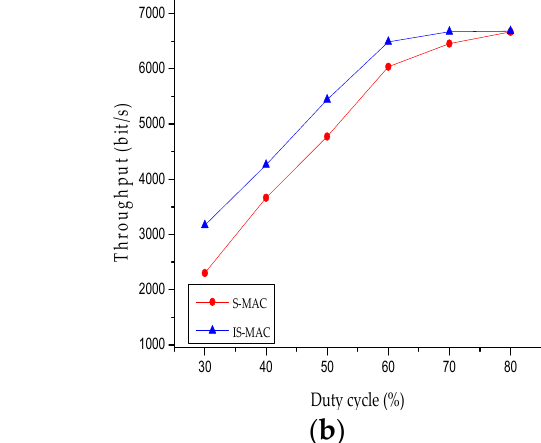
Figure 4. ( a ) Energy consumption of S-MAC protocol and IS-MAC protocol under different duty cycles; ( b ) throughput of S-MAC protocol and IS-MAC protocol under different duty cycles.